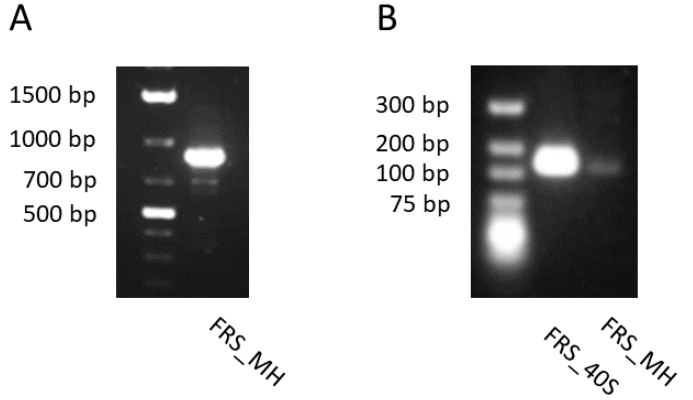
Figure 6. Amplified PCR product of the hypothetical FRS gene from the genomic DNA, spanning around 800 bp ( A ); and complementary DNA, spanning about 160 bp of G. heterophylla compares to 40S ribosomal protein as the reference gene, spanning around 160 bp ( B ).